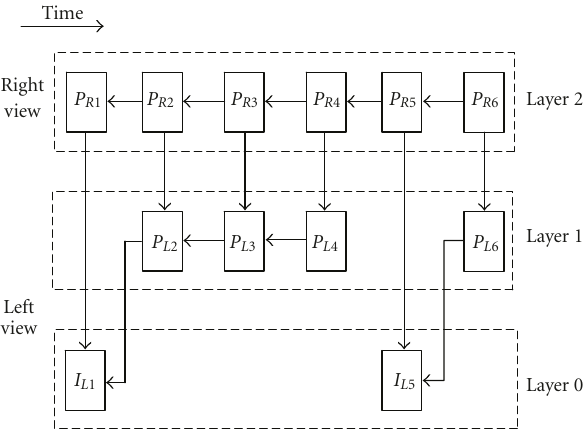
Figure 3: Layers of stereoscopic video and referencing